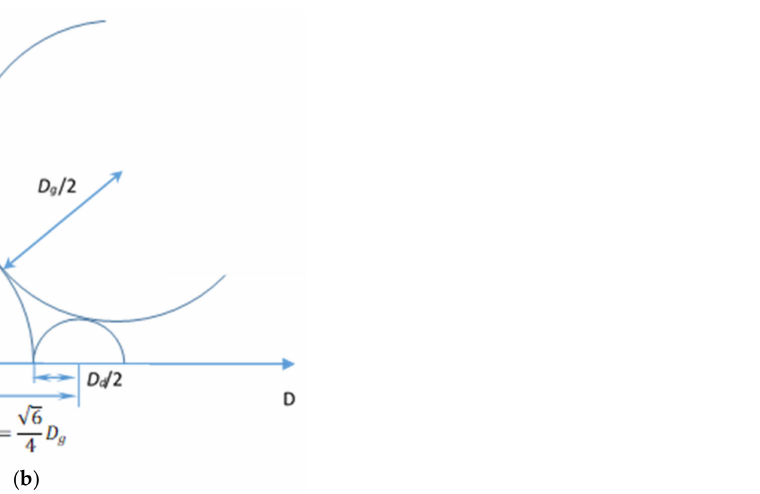
(cid:16) √ (cid:17) 6 − 1 D g . Source: authors own work 2